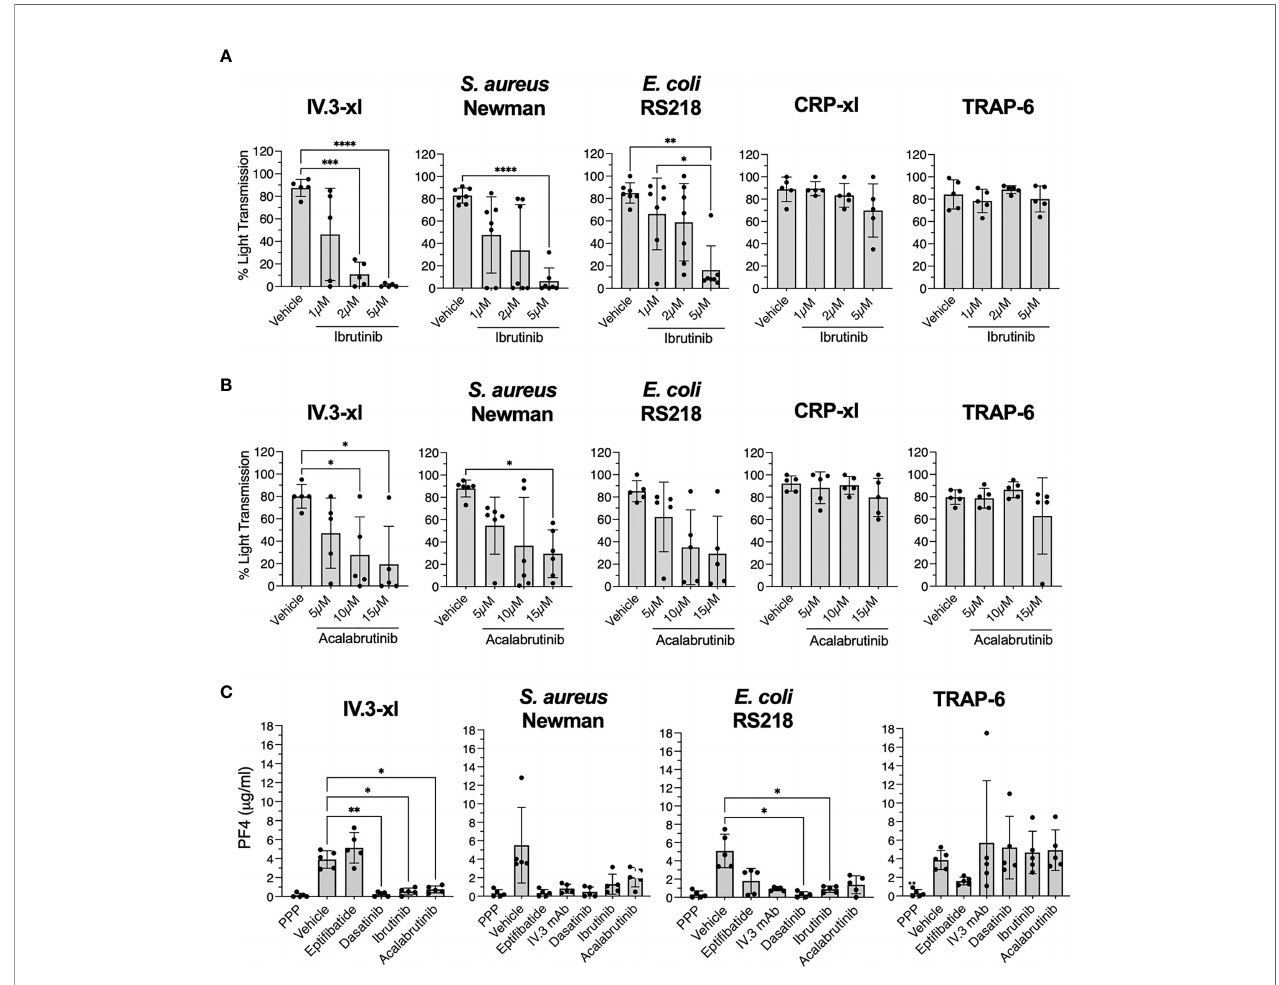
FIGURE 4 | Ibrutinib and acalabrutinib inhibit healthy control platelet activation by bacteria and IV.3 mAb mediated Fc g RIIA crosslinking in the presence of plasma. (A) Characterization of the effect of ibrutinib on platelet aggregation. PRP from healthy controls was incubated in vitro with different doses of ibrutinib for 5 minutes before stimulation with the following agonists: crosslinked IV.3 mAb (IV.3-xl; 4 m g/ml IV.3 mAb followed by 30 m g/ml F(ab ’ )2 rabbit anti-mouse IgG; n=5), S. aureus Newman (n=7), E. coli RS218 (n=7), 3 m g/ml CRP-xl (n=5) and 3 m M TRAP-6 (n=5). Aggregation was measured by light transmission aggregometry. Reactions were run for 20 minutes from onset of aggregation for IV.3-xl and bacteria, and 10 minutes for the rest of agonists, and maximum aggregation was calculated. (B) Characterization of the effect of acalabrutinib on platelet aggregation. PRP from healthy controls was incubated in vitro with different doses of acalabrutinib for 5 min before stimulating with agonists: IV.3-xl (n=5), S. aureus Newman (n=6), E. coli RS218 (n=5), 3 m g/ml CRP-xl (n=5) and 3 m M TRAP-6 (n=5). Aggregation was measured by light transmission aggregometry as above. (C) PRP from healthy controls (n=5) was incubated with vehicle or inhibitors, 9 m M epti fi batide ( a IIb b 3 inhibitor), 20 m g/ml IV.3 mAb (to inhibit Fc g RIIA), 4 m M dasatinib (Src inhibitor), or iBtks, 5 m M ibrutinib and 15 m M acalabrutinib. Samples were then stimulated with stated agonists. Supernatants from aggregation reactions were collected at 20 minutes of onset of aggregation for IV.3-xl and bacteria, and 10 minutes for TRAP-6. Levels of PF4 as a marker of a -granule secretion were measured by PF4 ELISA. Data is shown as mean ± SD. Statistical signi fi cance was calculated using one-way ANOVA followed by Tukey ’ s multiple comparison correction (*p ≤ 0.05, **p ≤ 0.01, ***p ≤ 0.001, ****p ≤